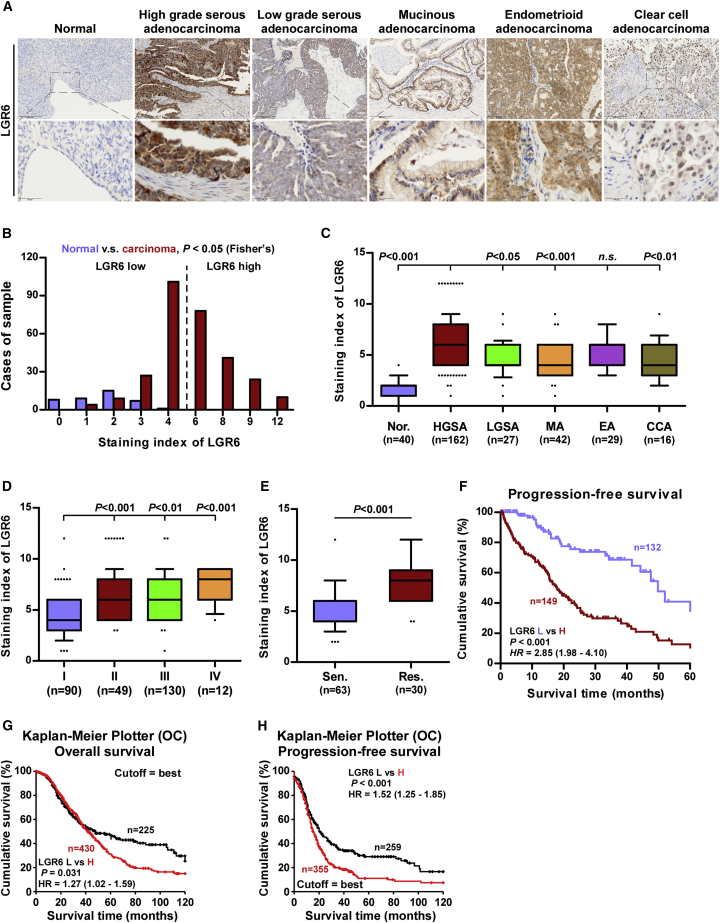
High Levels of LGR6 Predicts Poor Prognosis in Ovarian Cancer Patients(A) Representative images of LGR6 expression in normal ovarian epithelial tissues and ovarian cancer tissues with different histologic types. (B) The number of ovarian cancer tissues stratified by staining index of IHC. (C) Staining index of LGR6 in different histologic types of ovarian cancer. Error bar represents the 10th–90th percentile. (D) Staining index of LGR6 in different FIGO stages of ovarian cancer. Error bar represents the 10th–90th percentile. (E) Staining index of LGR6 in chemosensitive and chemoresistant ovarian cancer. Error bar represents the 10th–90th percentile. (F) Kaplan-Meier analysis of progression-free survival curves for ovarian cancer patients stratified by high and low expression of LGR6. (G and H) Kaplan-Meier overall survival (G) and progression-free survival (H) curves for ovarian cancer patients stratified by high and low expression of LGR6 in ovarian cancer dataset from Kaplan-Meier plotter.